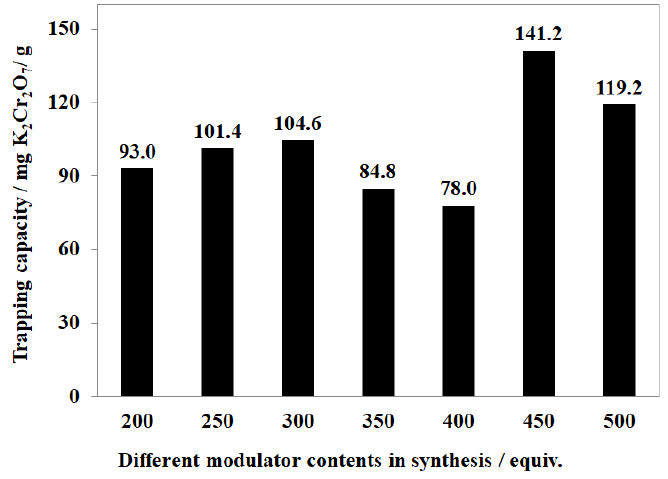
Figure 11. K 2 Cr 2 O 7 trapping capacity of different MOF-808 samples synthesized with various formic acid concentrations in the synthesis phase.